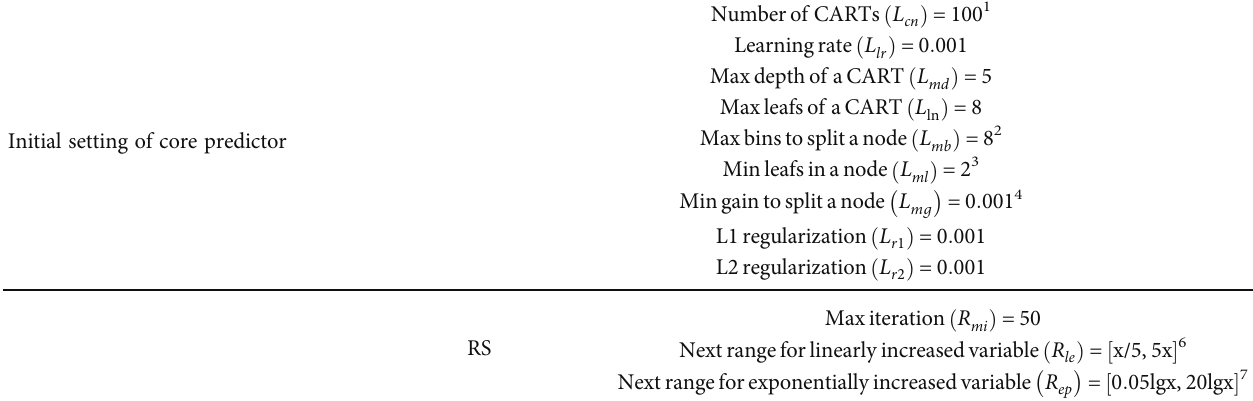
Initial setting of core